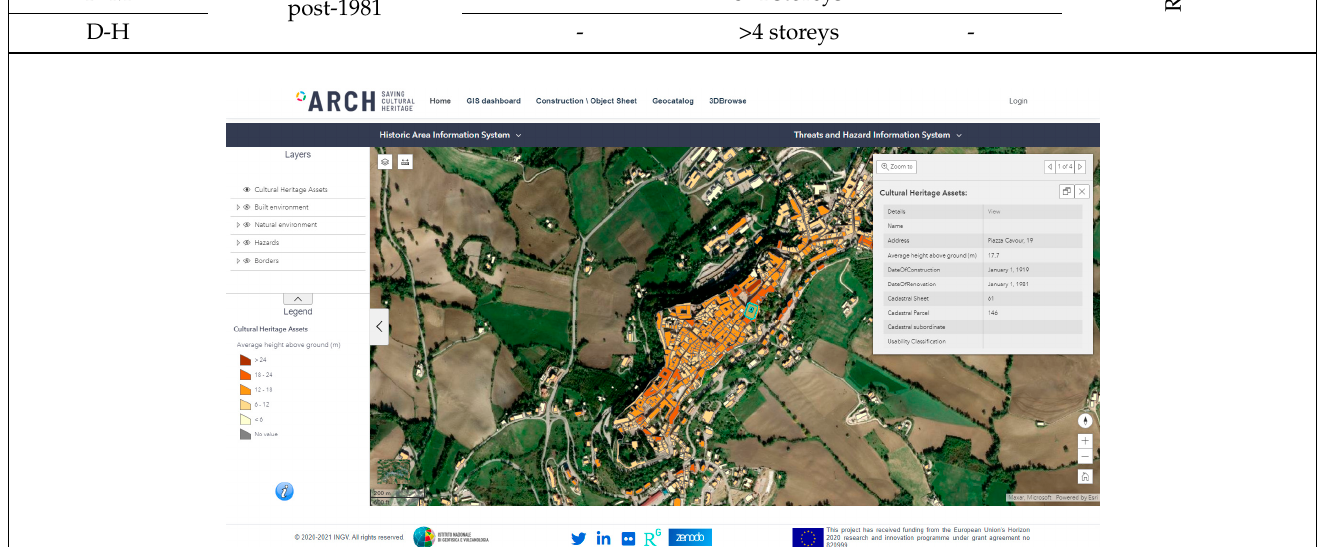
Figure 1. Tools of the ARCH Historic Area Information System: GIS platform with information about the historic